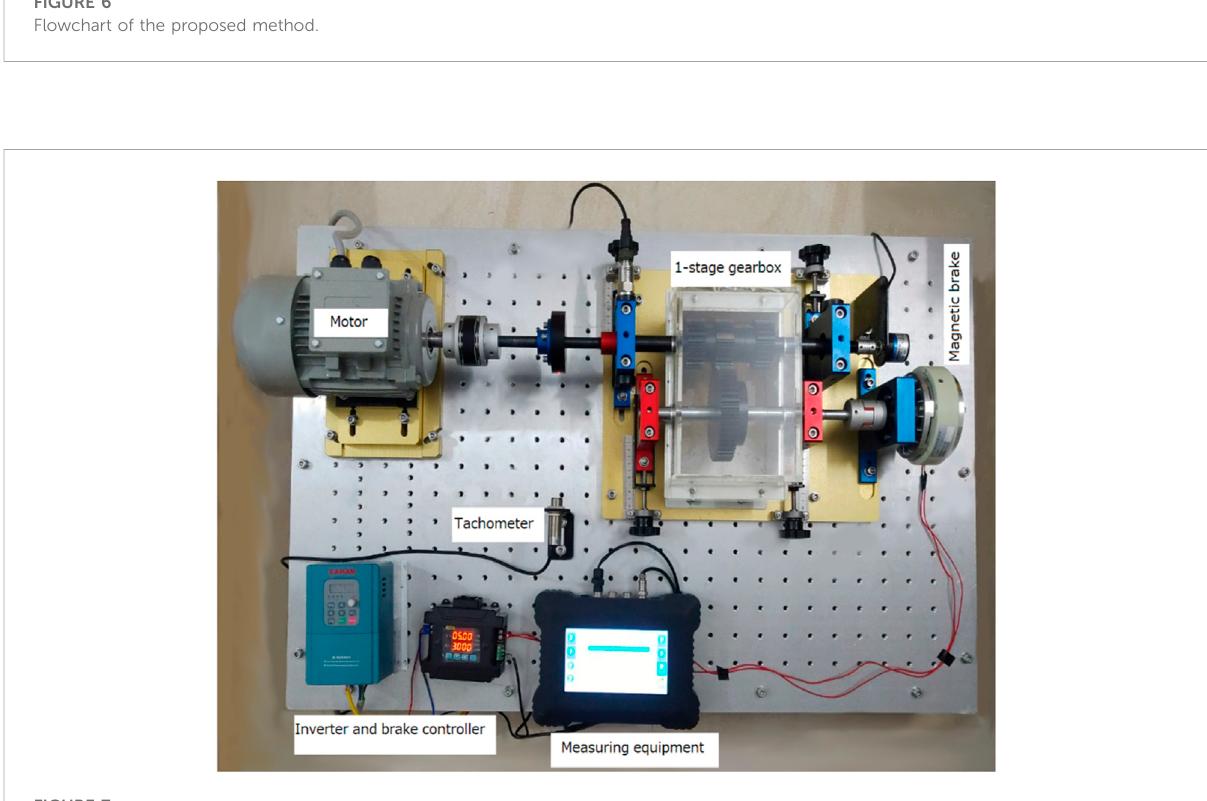
FIGURE 7 Actual experimental